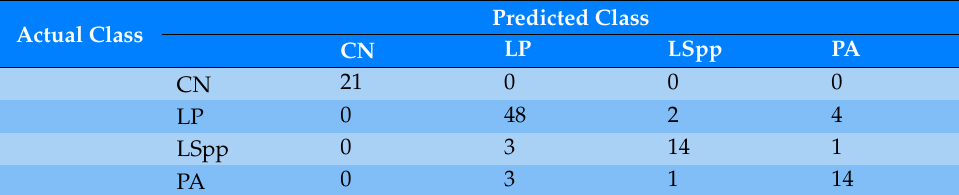
Table 1. Confusion matrix obtained via k-NN classification model calculated using gas sensor array data, considering Euclidean distance and k = 1. The elements on the diagonal correspond to correctly classified measurements.